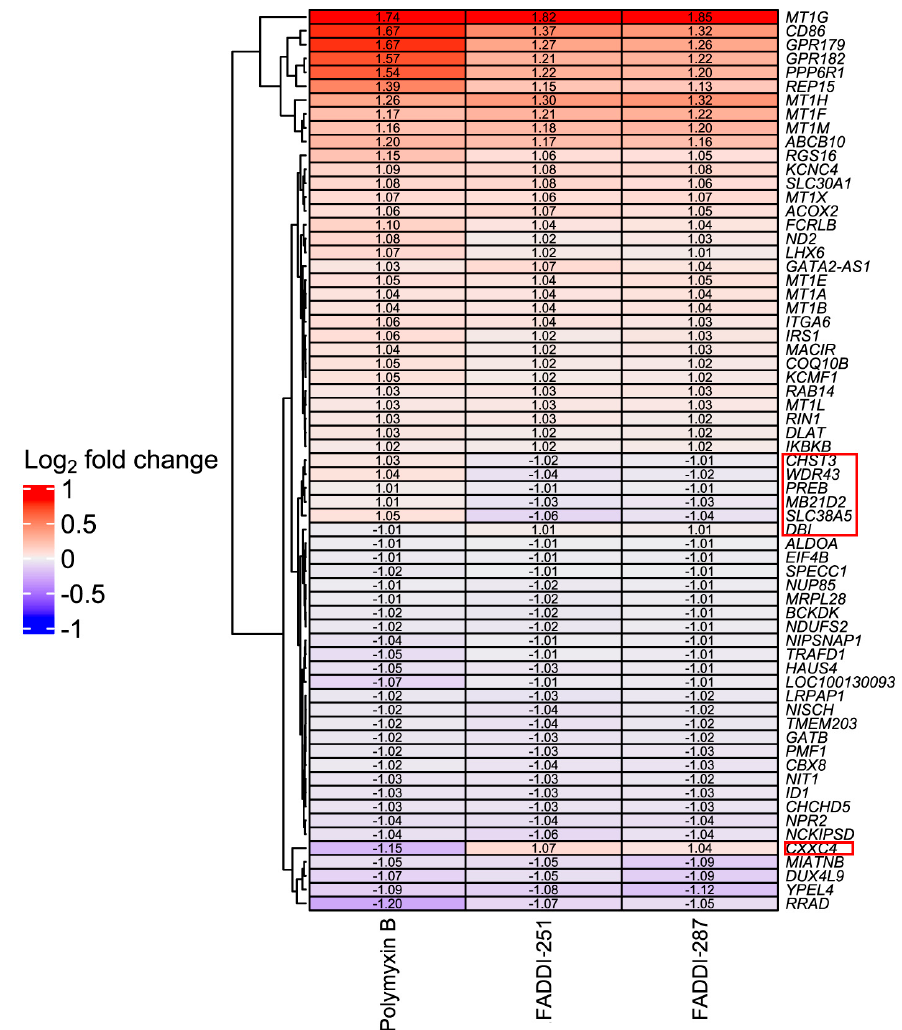
Figure 4. Heatmap of common DEGs and Log 2 fold changes in HK-2 cells induced by polymyxin B, FADDI-251 and FADDI-287. Inconsistently changed genes across three treatments are indicated by the red boxes on the right. Table 1. Top 10 pathways enriched by 58 DEGs common to treatments by polymyxin B, FADDI- 251 and FADDI-287.